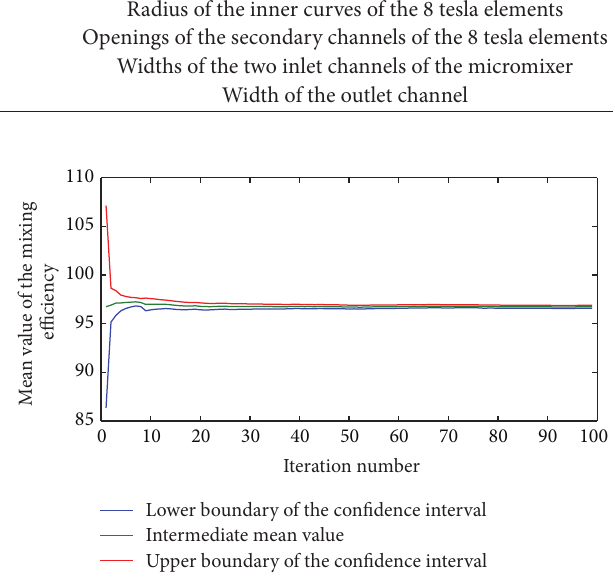
Figure 7: Convergence plot of the Monte Carlo simulation for the micromixer with 8 connected tesla